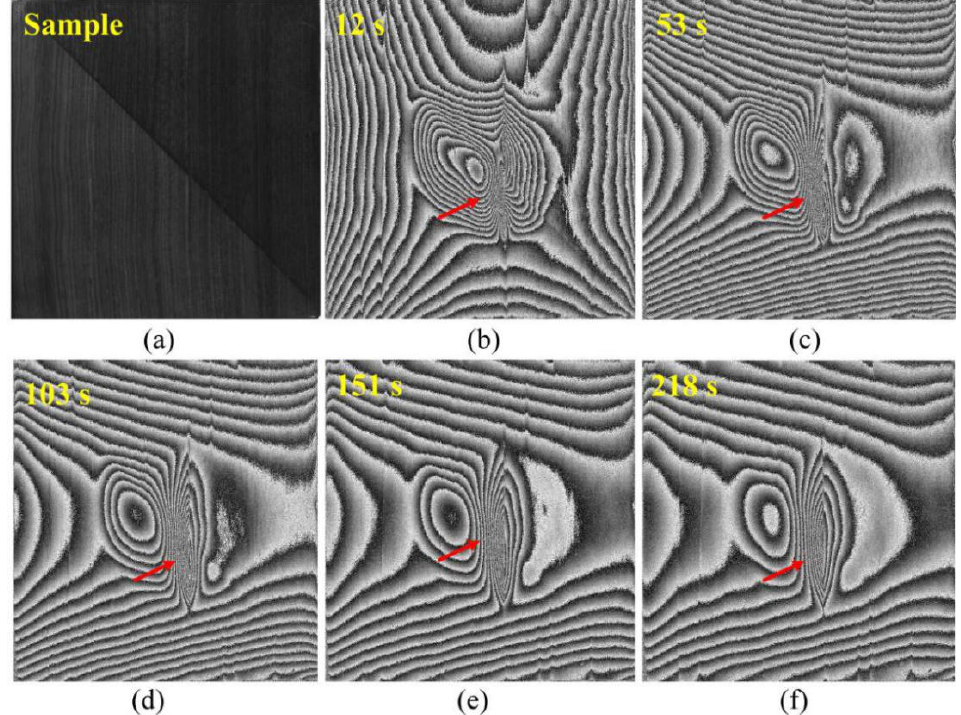
Figure 8. Captured data: ( a ) Measured sample; ( b )–( f ) estimated phase maps at 12 s, 53 s, 103 s, 151 s, and 218 s, respectively.